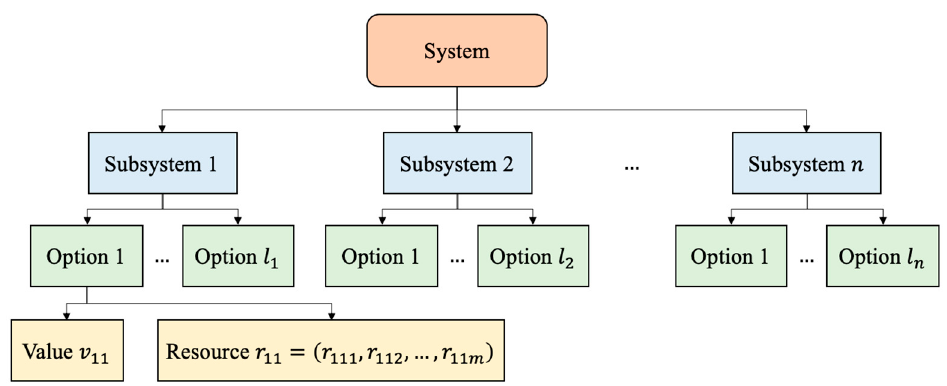
Figure 1. Description of a system composed of multiple subsystems and multiple options for each subsystem.